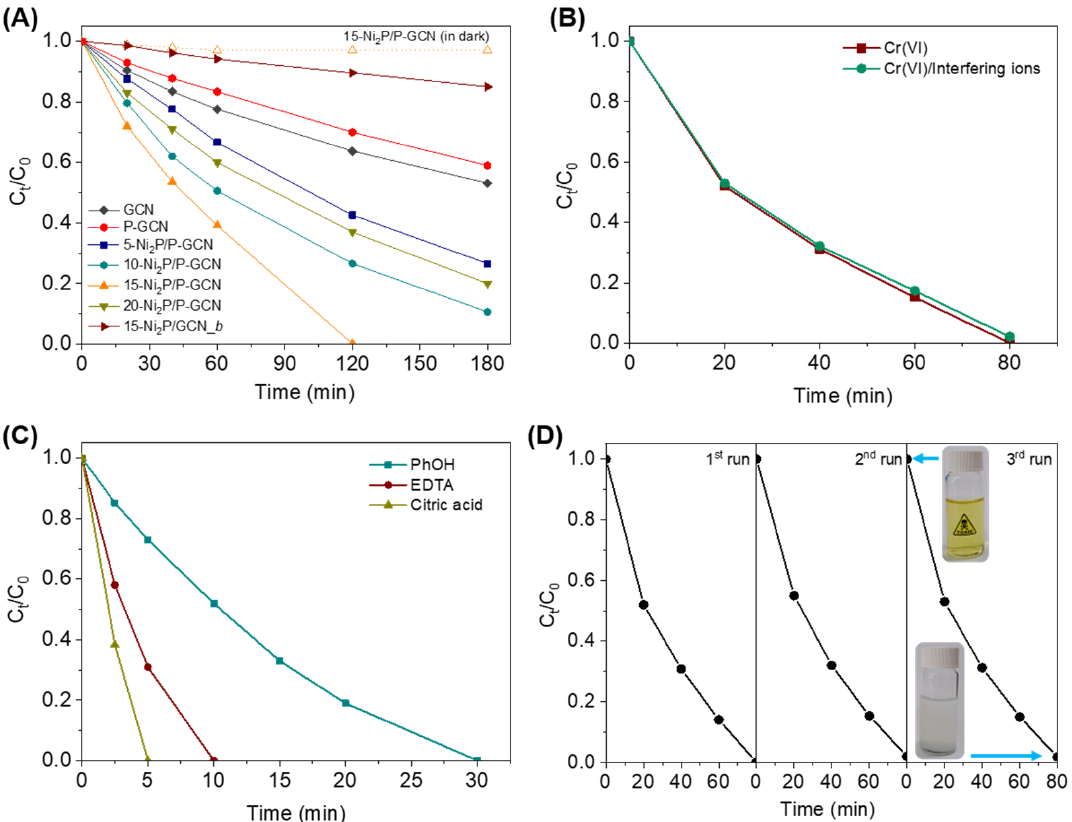
Figure 4. Photocatalytic reduction of aqueous Cr(VI) solution over ( A ) different catalysts (The time evolution of the Cr(VI) reduction over the 15-Ni 2 P/P-GCN catalyst in the dark is also given), ( B ) 15-Ni 2 P/P-GCN without and with the presence of various interfering ions (SO 42– , CO 32– , NO 3– , Cl − , Na + , Cu 2+ , Mn 2+ and Zn 2+ ) and ( C ) 15-Ni 2 P/P-GCN in the presence of three equivalents of phenol (PhOH), ethylenediaminetetraacetic acid (EDTA) and citric acid. ( D ) Recycling study of 15-Ni 2 P/P-GCN catalyst in the photocatalytic reduction of Cr(VI). All the photocatalytic experiments were performed as follows: 0.8 g · L − 1 (or 0.4 g · L − 1 for catalytic tests in panel A) catalyst, 50 mg · L − 1 Cr(VI) solution, pH = 2, λ > 360 nm light irradiation, 20 ◦ C. 2HCrO 4 − (aq) + 8H + (aq) → 2Cr 3+ (aq) + 3 / 2 O 2(g) + 5H 2 O (l) (1) Under optimal reaction conditions (0.8 g · L − 1 catalyst load), the photoreduction rate of Cr(VI) over 15-Ni 2 P/P-GCN reaches 15.9 µ mol · h − 1 at pH 2 under UV-visible ( λ > 360